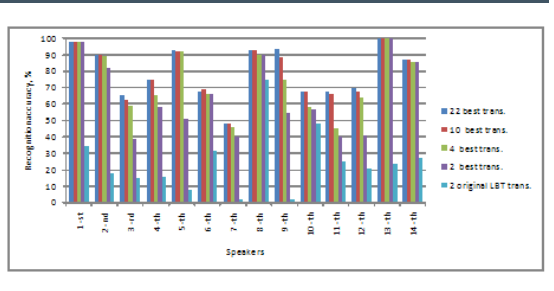
Figure 7. The recognition accuracy comparison, between all LBT based transcriptions, and the two best and single best it- eratively selected